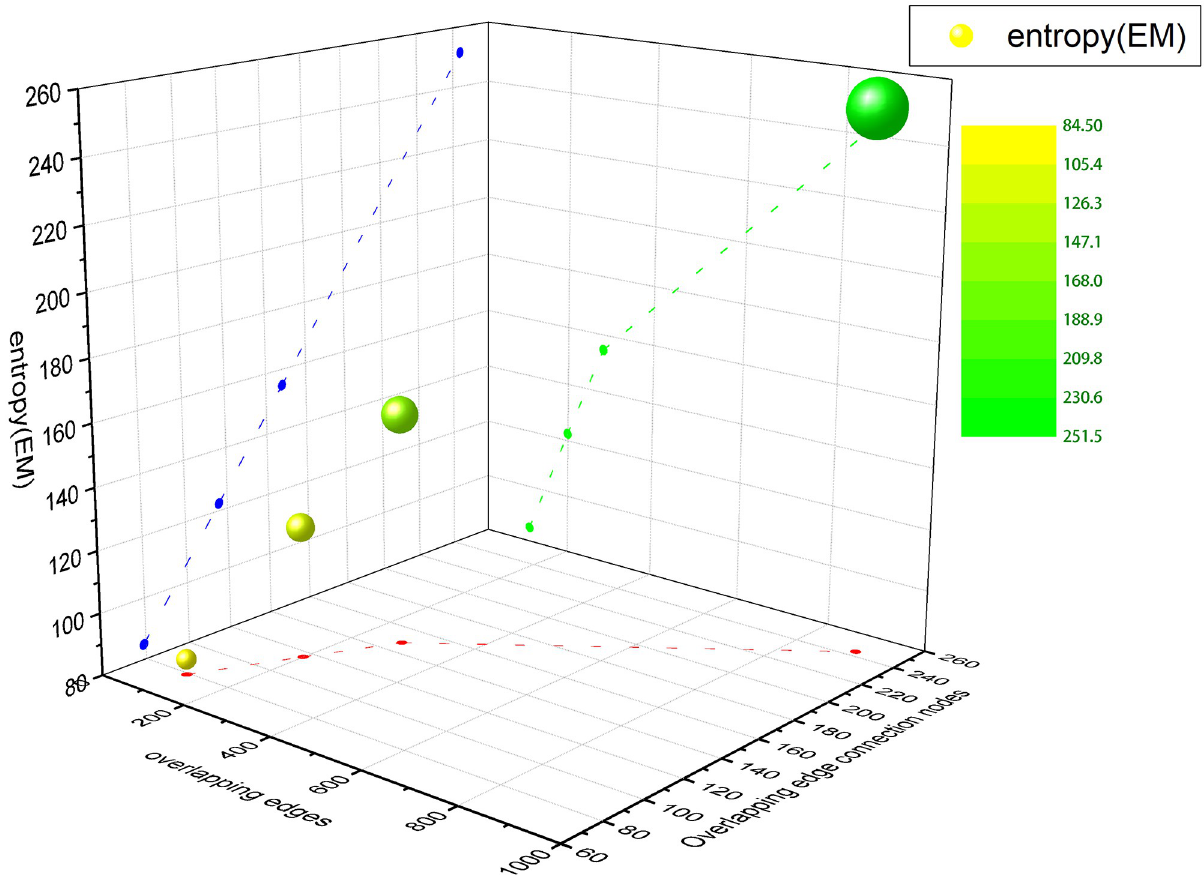
Fig 6. Three-dimensional coordinate scatter plot of C. elegans multiplex network. The green scatter shows that the structure entropy has a positive trend about the overlapping edges. The blue scatter shows that the structure entropy is linearly increasing with respect to the overlapping edge connected